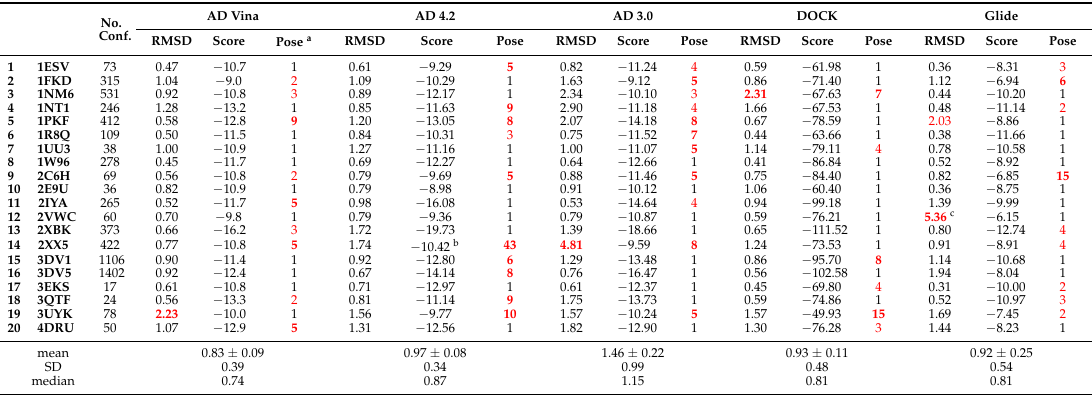
Table 4. RMSD values (in Å) and scoring energies for the best poses (the lowest RMSDs) of 1 – 20 . No.